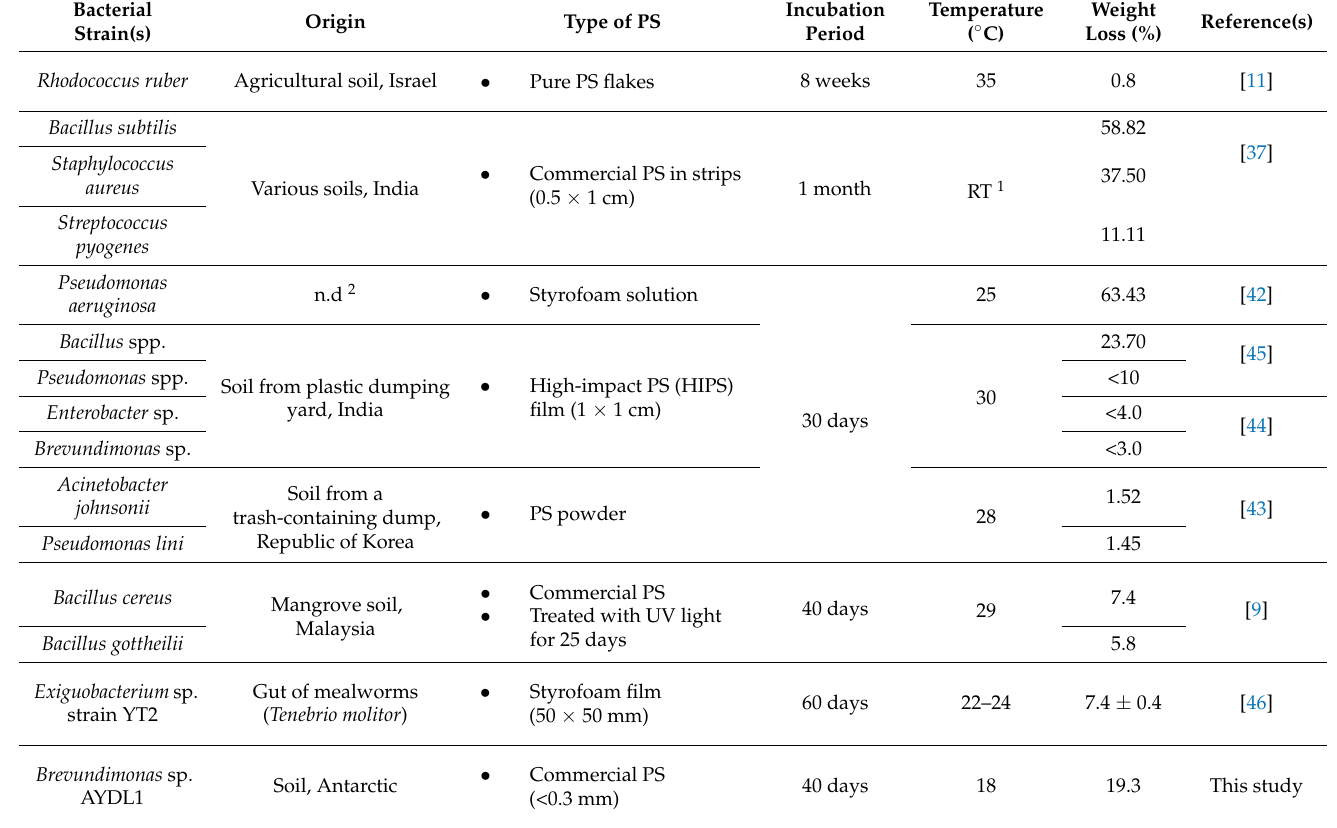
Table 3. Previous and current studies of PS microplastic utilisation by